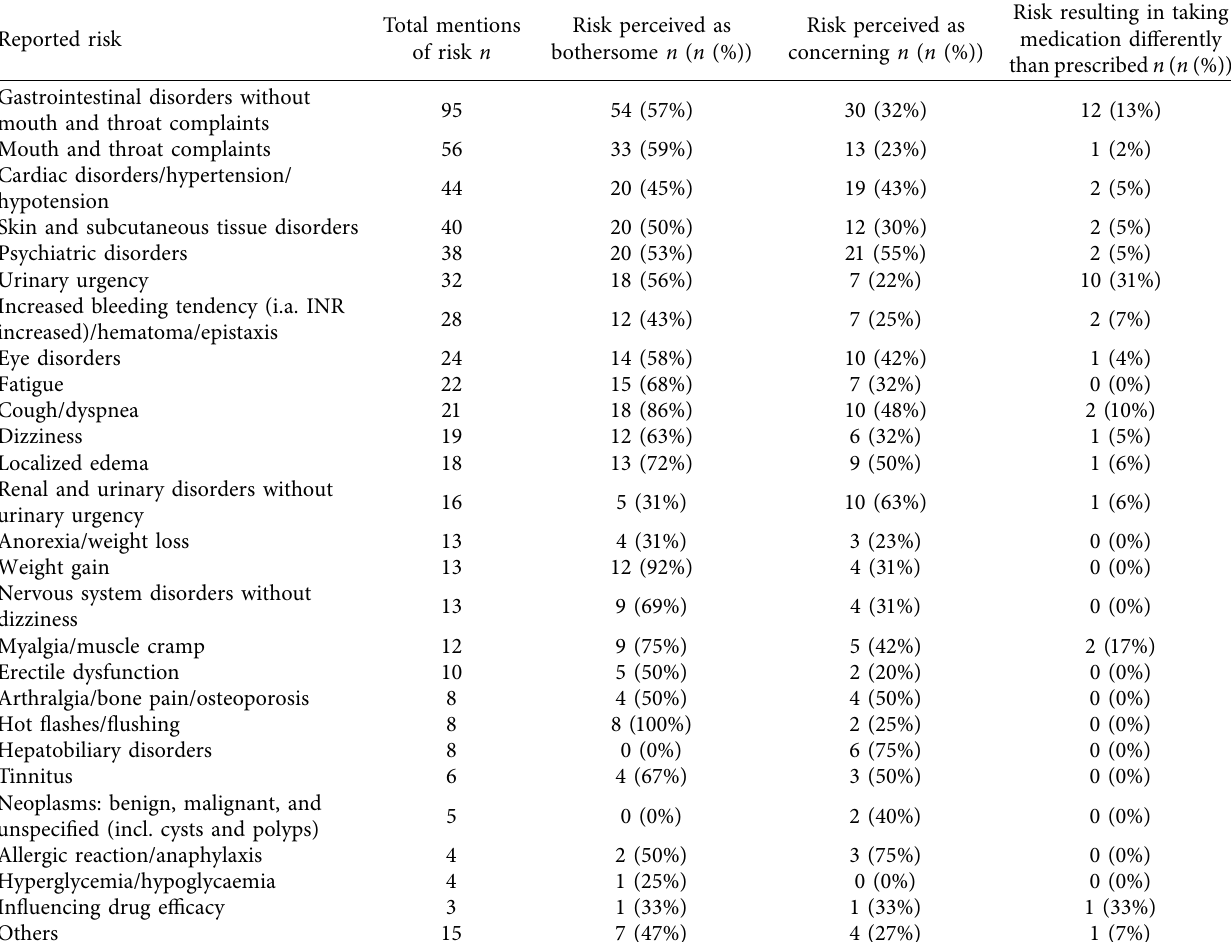
Table 2: Frequencies of whether a mentioned risk was perceived as bothersome, concerning, or led the patients to take their medication diferently than prescribed. Percentages are based on the total number of mentions of the respective risk. Reported risk